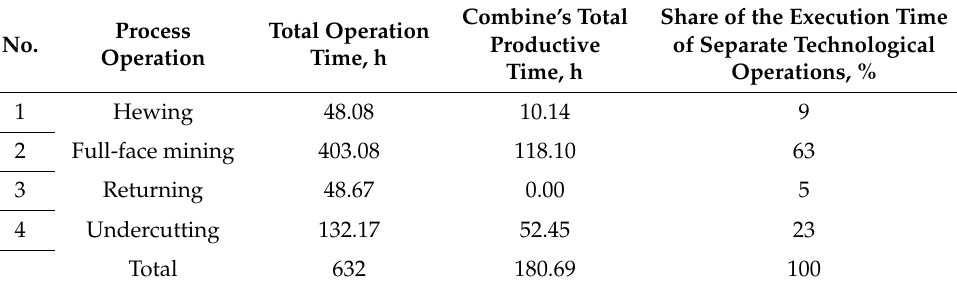
Table 1. Productive time of the Ural-20R-11 combine in various technological operations.